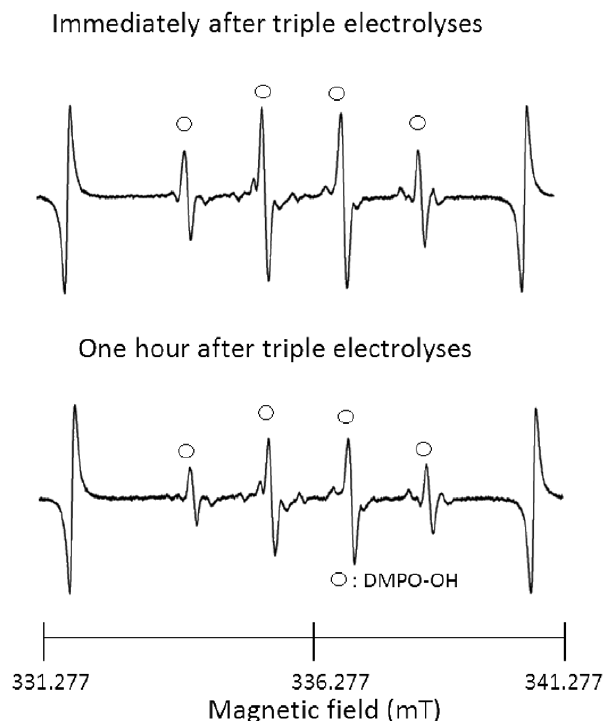
Figure 2. ESR spectra of AEW from triple electrolyses of 1% (w/ v) NaCl solution. Spectra immediately after production and after 1-h storage at room temperature under light-shielding conditions are shown.